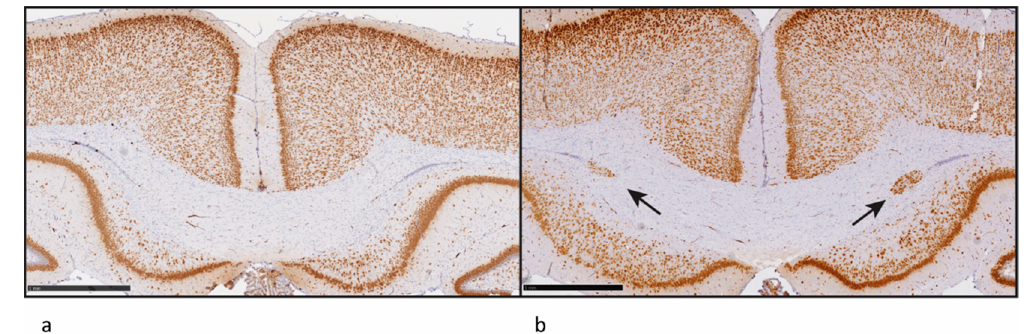
Figure 4. Heterotopia—misplaced cells in the corpus callosum of rats. Panel ( a ), left, shows the appearance of the corpus callosum in a control rat. Panel ( b ), right, shows heterotopia in the corpus callosum of a rat exposed in foetal life and postnatally to propylthiouracil (maternal dose: 2.5 mg / kg d). The arrows point to the misplaced cells. Scale bars: 1 cm.